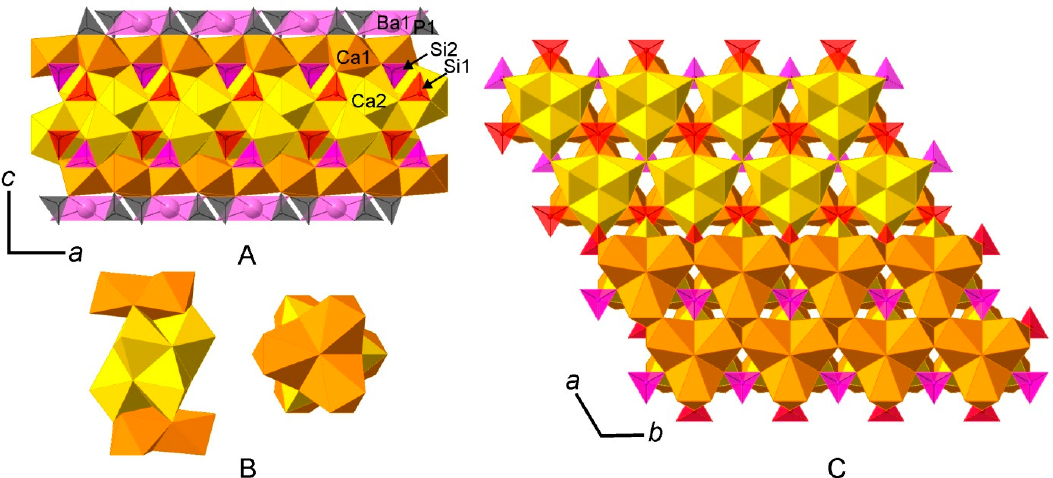
Figure 4. Using a cation-centered representation of the ariegilatite structure ( A – C ), the antiperovskite module can be decomposed into four layers assembled of triplets of Ca coordination polyhedra. Structural voids within each layer accommodate the silicate tetrahedra. Perpendicular through the layers, columns of four Ca-triplets can be identified. These are shown in a projection along c and [010] in ( B ). The layers of Ca-triplets are connected by common anions in octahedral coordination: Ca1 and Ca2 layers are sharing F1; Ca2 and Ca2 are connected by O7. In ( C ), two layers of Ca-triplets are removed at the top half of the image.